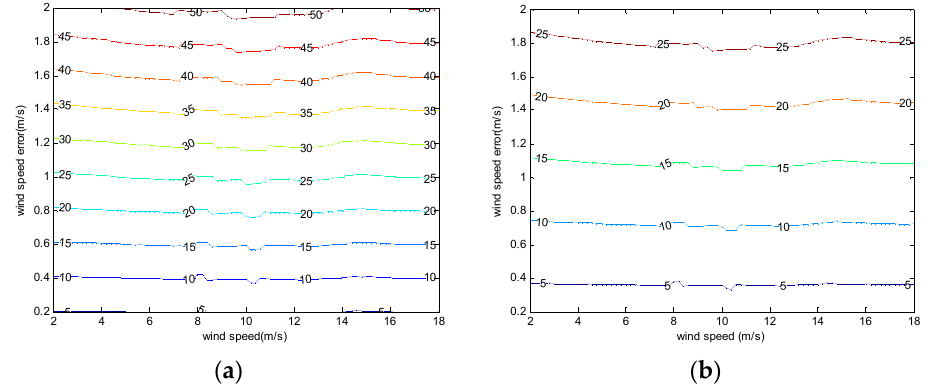
Figure 1. Surface Doppler shift errors due to different wind speed errors in the downwind direction: ( a ) received and transmitted in horizontal polarization (HH polarization); ( b ) received and transmitted in vertical polarization (VV polarization).